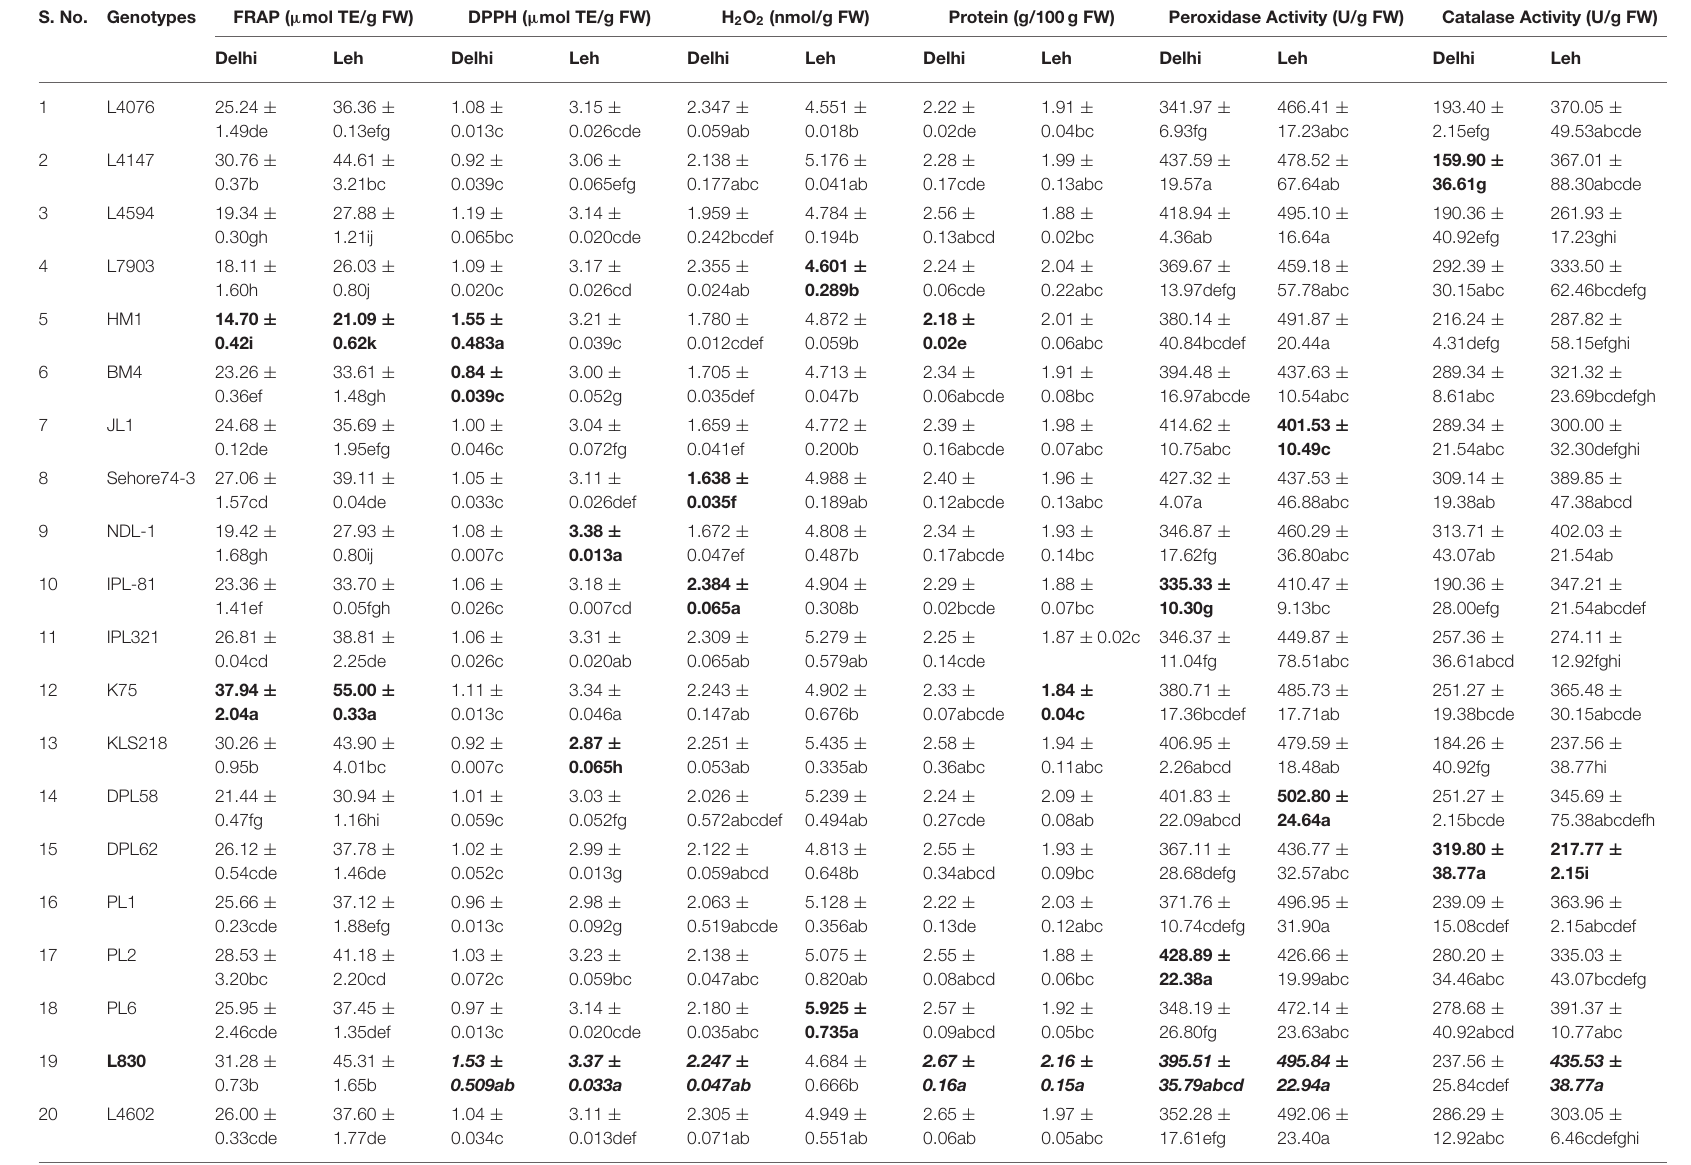
TABLE 4 | Total antioxidant activity, crude protein, and enzymatic antioxidant activities of lentil microgreens grown under Delhi and Leh environmental conditions. S. No.